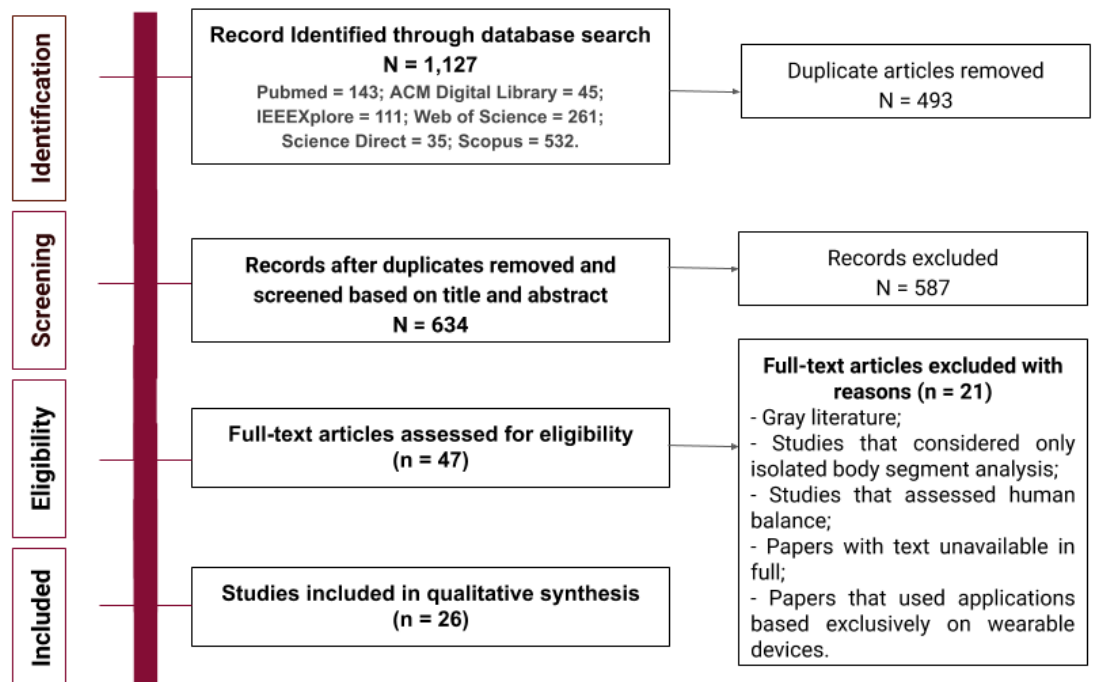
Figure 3. Flow diagram of the review process.